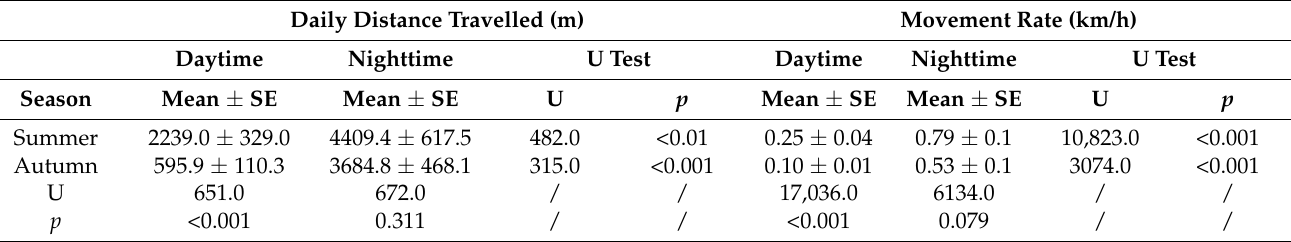
Table 3. Nocturnal and diurnal daily distance travelled and movement rate during the summer and the autumn. Kruskal–Wallis ANOVA tested differences for multiple comparisons and Mann–Whitney U Test for pairwise comparisons.